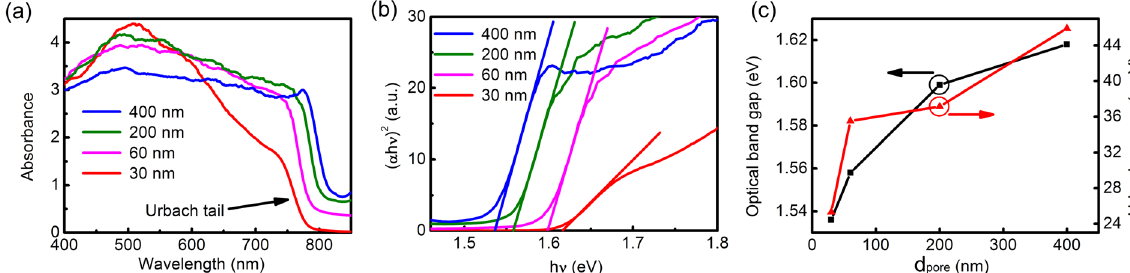
Figure 3. ( a ) UV-vis absorption spectrum of the films on AAO templates with different size of pores; ( b ) Tauc plot according to the absorption coefficient to estimate the band gap of the perovskite films; ( c ) Optical band gaps and Urbach energies of the perovskite films.